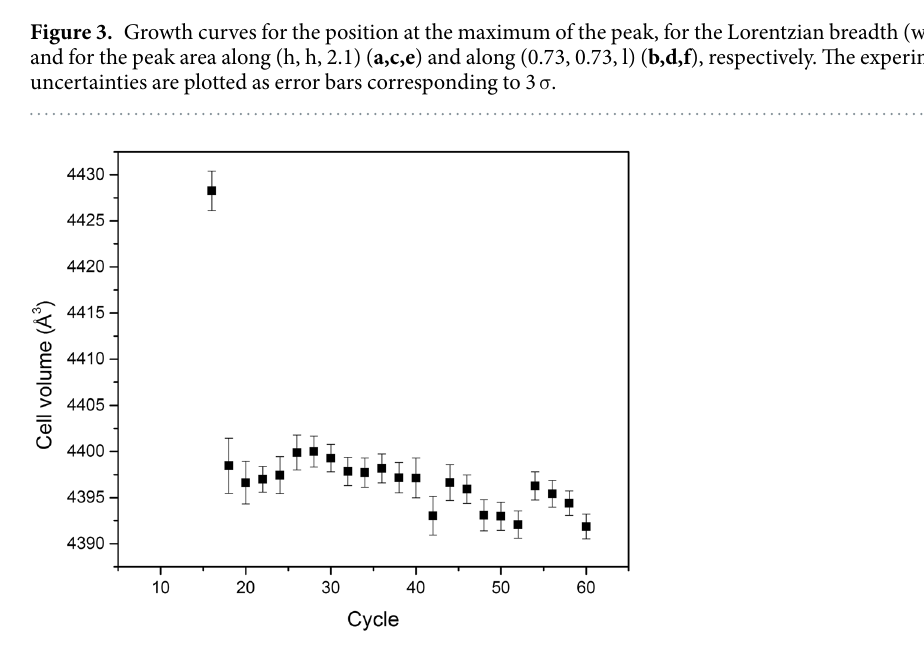
Figure 4. Cell volume in Å 3 during the growth of the film. The experimental uncertainties are plotted as error bars corresponding to 3 σ